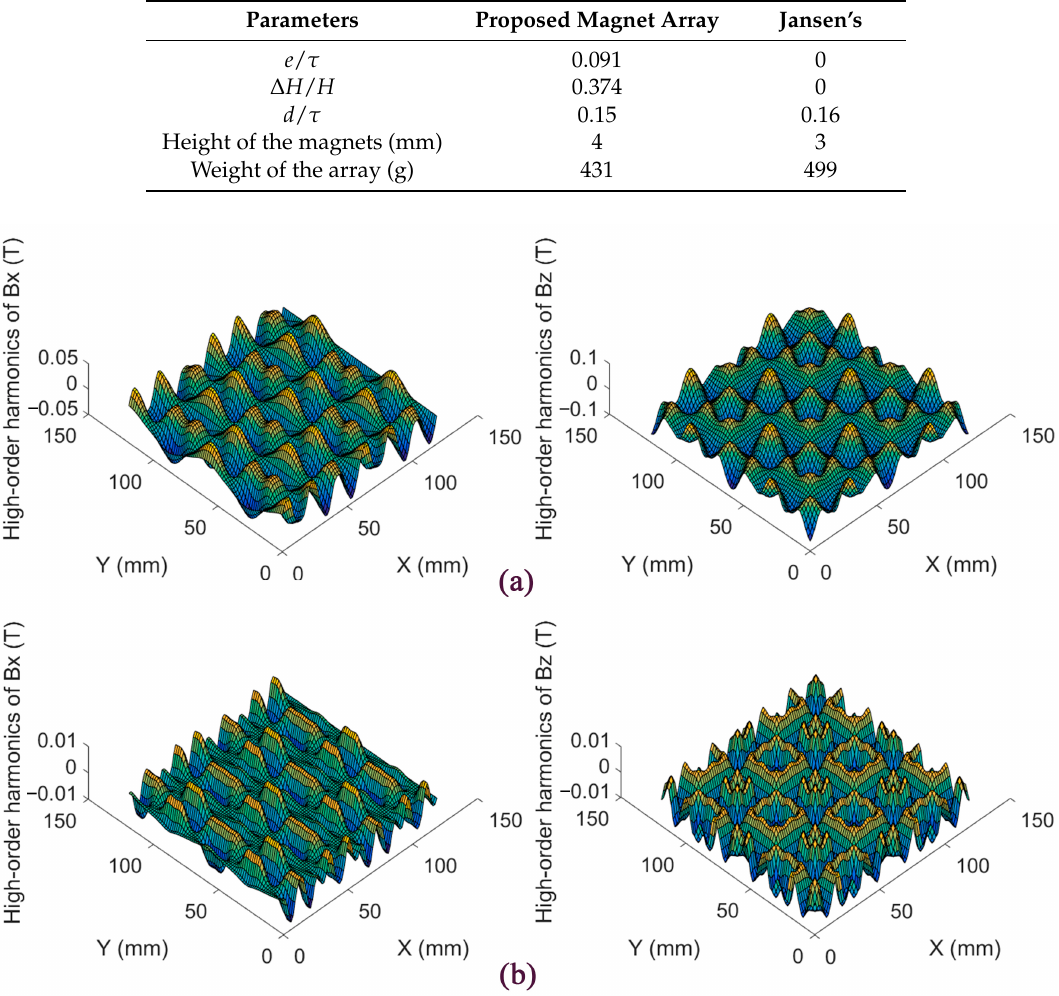
Table 3. Parameters for the proposed magnet array and Jansen’s.